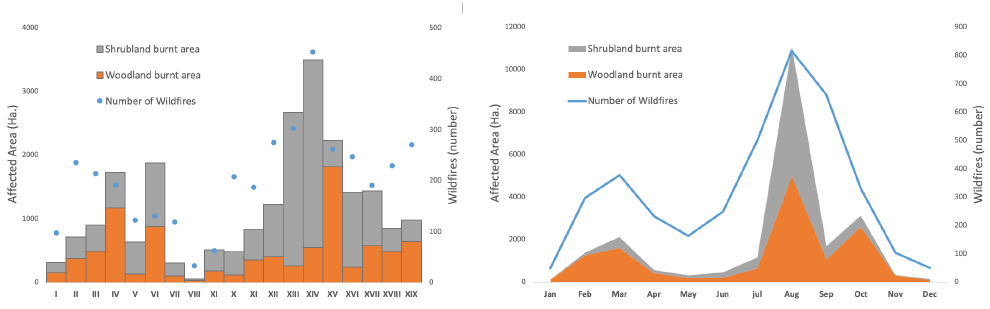
Figure 3. Average number of fires, affected woodland area and damaged shrub area (in hectares) in Galicia. Left: per forest district; Right: per month (data obtained from the Galician Statistical Office